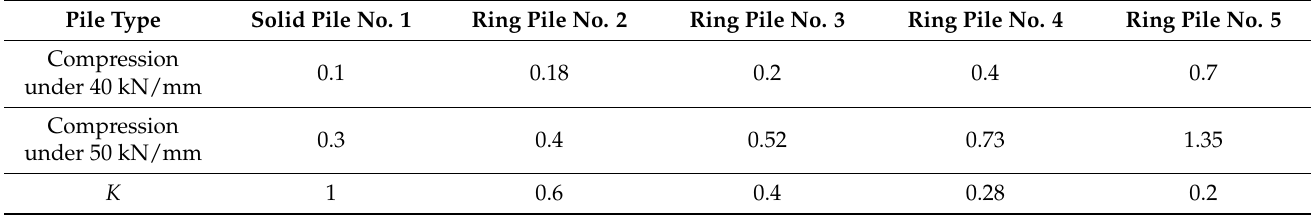
Table 4. Comparison of compression in model piles.